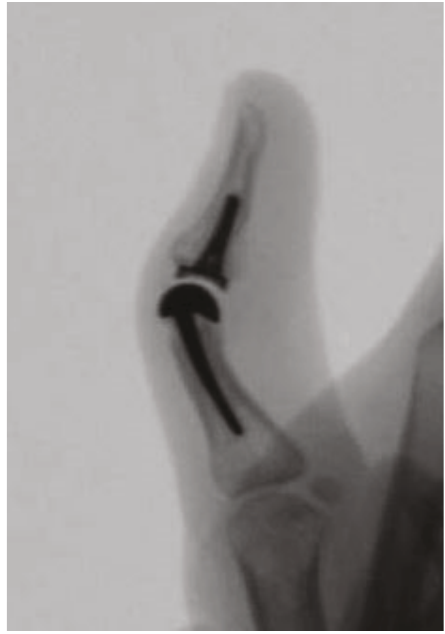
Figure 4: Lateral view of the thumb IP joint with the implant in